Question: How would you classify this visualization?
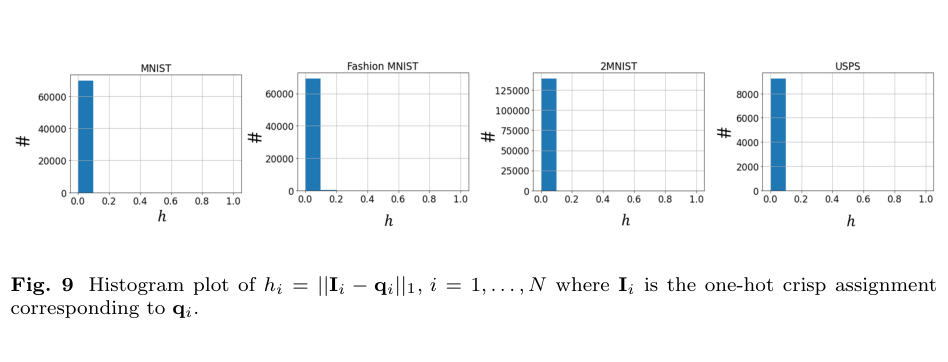
Answer: histogram